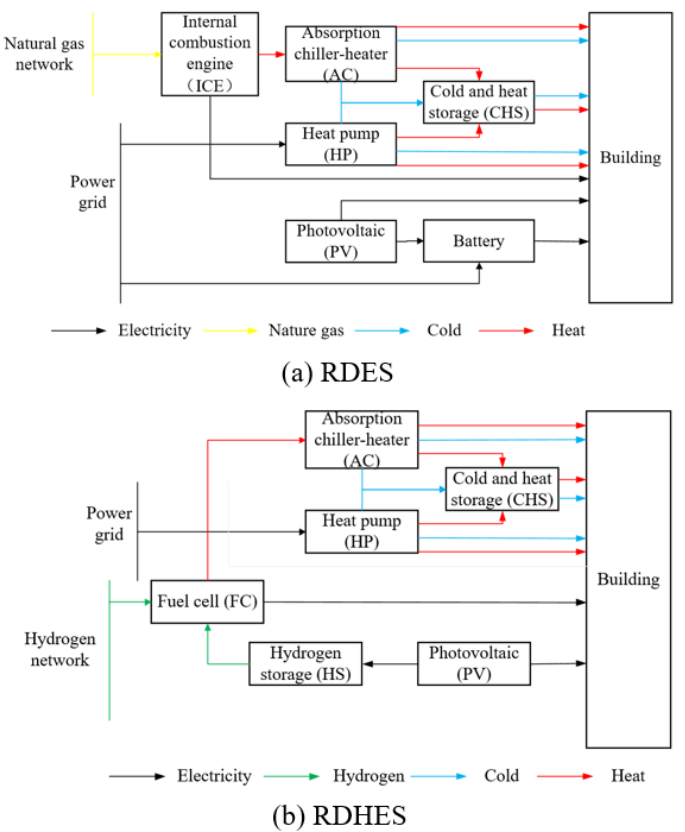
Figure 1. Description of the main equipment and energy flow in a conventional RDES ( a ) and RDHES ( b ).